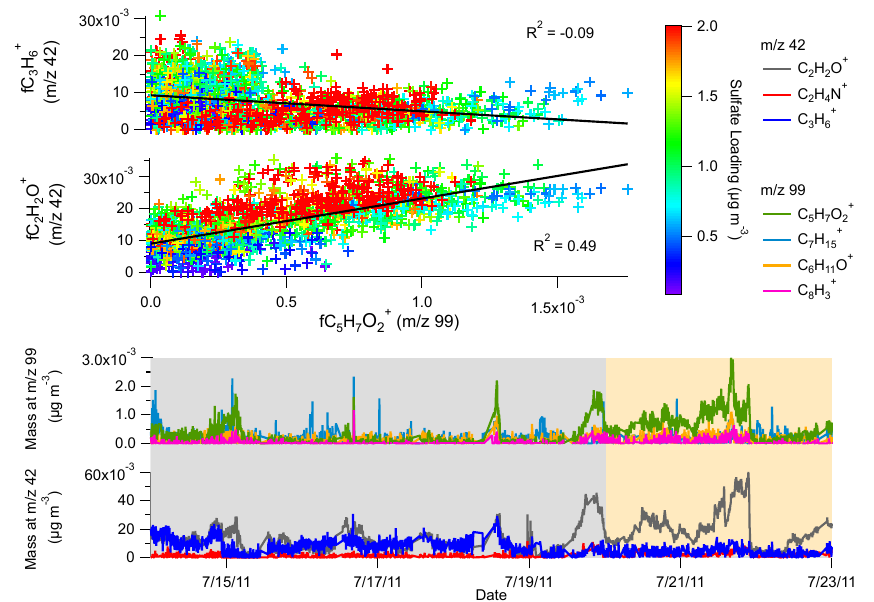
Fig. A3. Top – variation of C 2 H 2 O + and C 3 H + at m/z 42 with C 5 H 7 O + at m/z 99. Markers are colored by sulfate loading. Bottom – time 6 2 series trend showing the variation of the ions at m/z 42 and 99. Region shaded grey corresponds to the clean period of the cruise, region shaded light brown corresponds to the perturbed period of